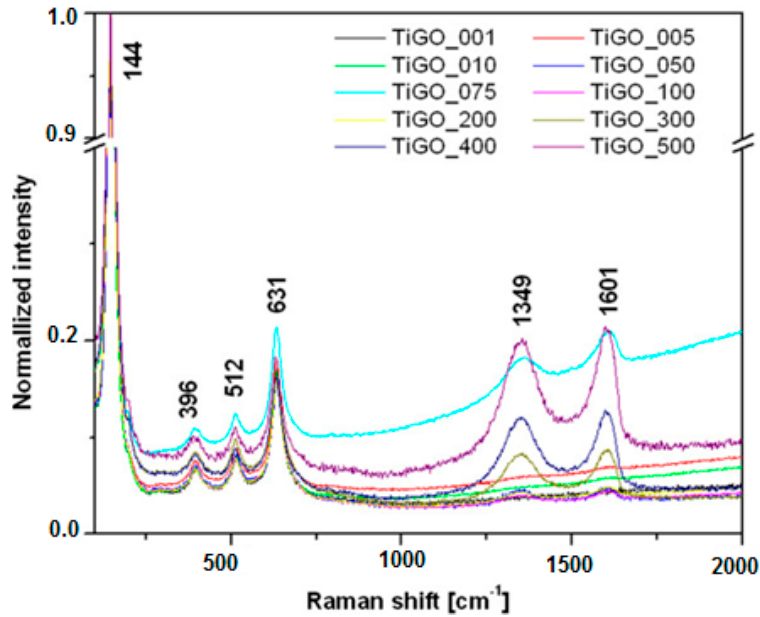
Figure 23. Raman spectra of TiO 2 /GO nanocomposites with different GO amounts, adapted from reference [16].